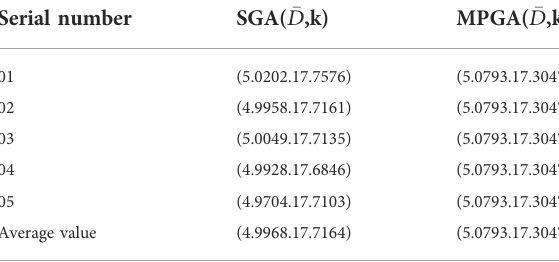
TABLE 2 Comparison of inversion results between SGA and MPGA.